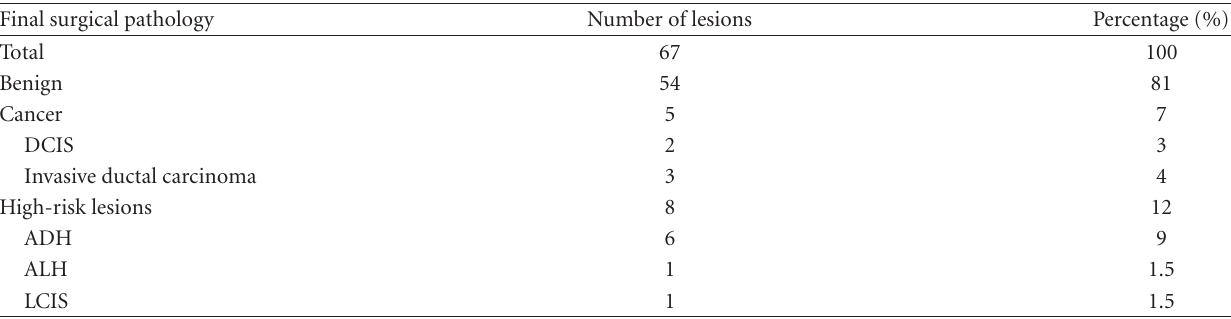
Table 1: Final pathology of 67 lesions following surgical excision.